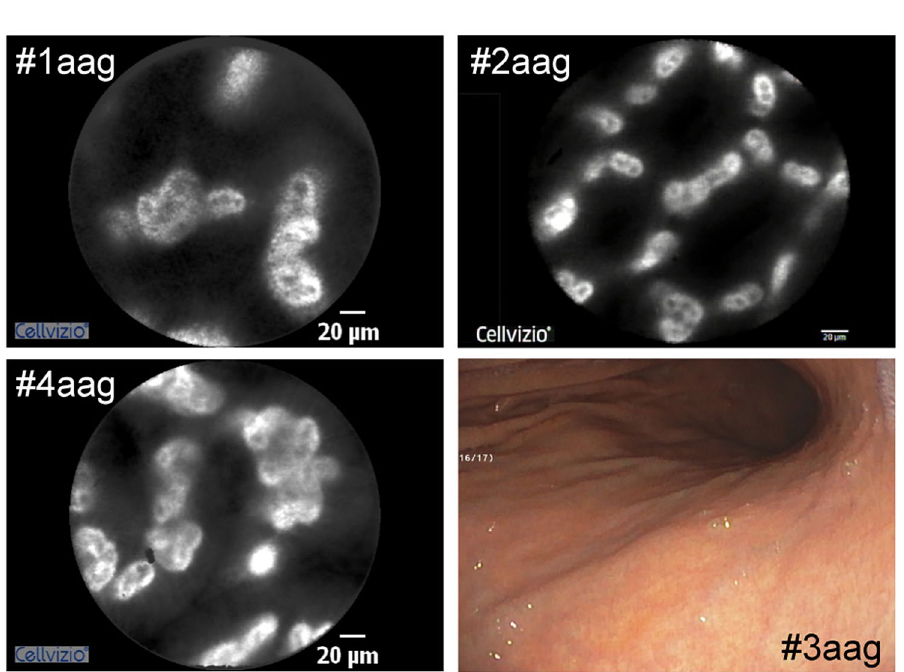
Figure 2. Representative pCLE images of the gastric mucosa of three patients (#1, #2 and #4) affected by atrophic autoimmune gastritis (aag). The endoscopy image of patient #3aag is shown as a representative example of standard atrophic